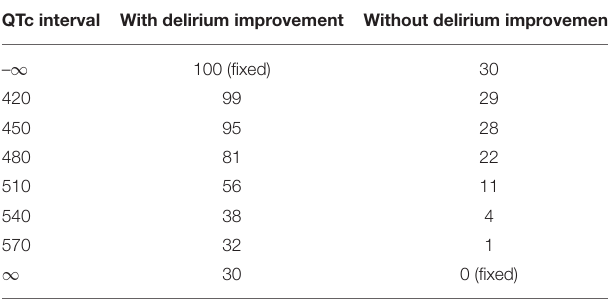
TABLE 2 | Default utility values based on a sigmoid